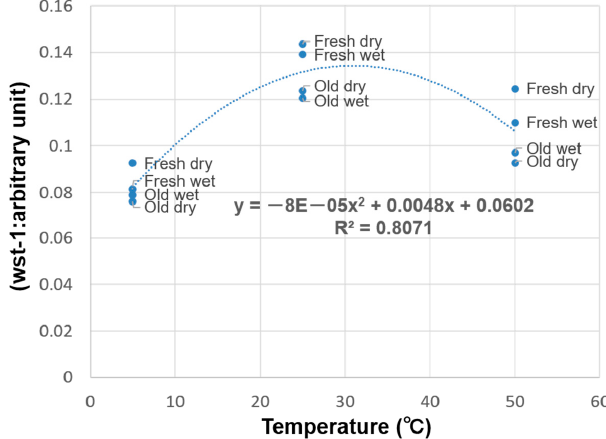
Figure 5. Regression analysis of titanium temperature and cell attachment using a quadratic curve ( R 2 = 0.81).